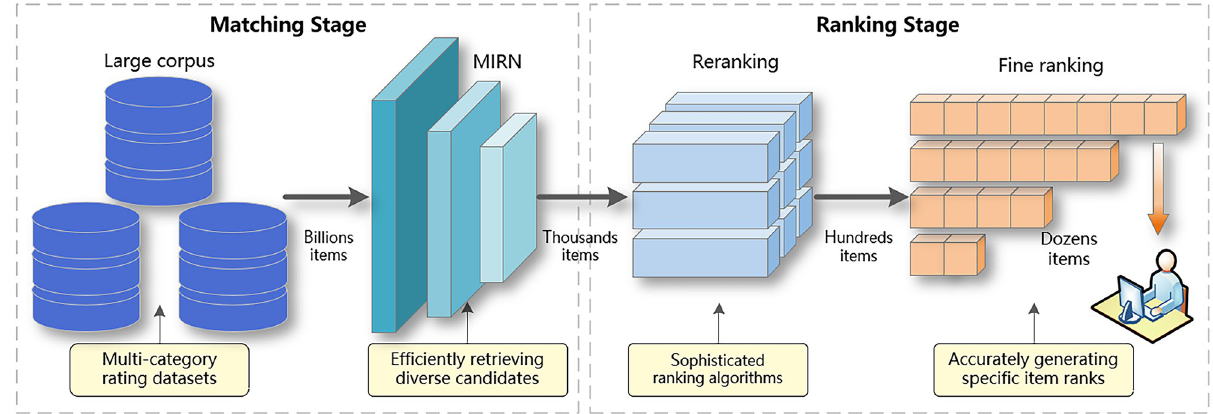
Fig 1. An illustrative diagram shows how to use MIRN in an industrial recommendation system. MIRN focuses on the matching stage, which aims to retrieve user-interested items efficiently. Note that the matching stage is concerned with retrieving good items, rather than specific item ranks.